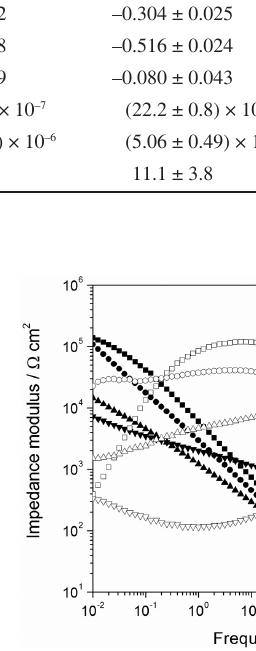
Figure 4. Bode diagrams of sintered 316L stainless steel and HA- 316L composites in Ringer’s solution at room temperature and at corrosion